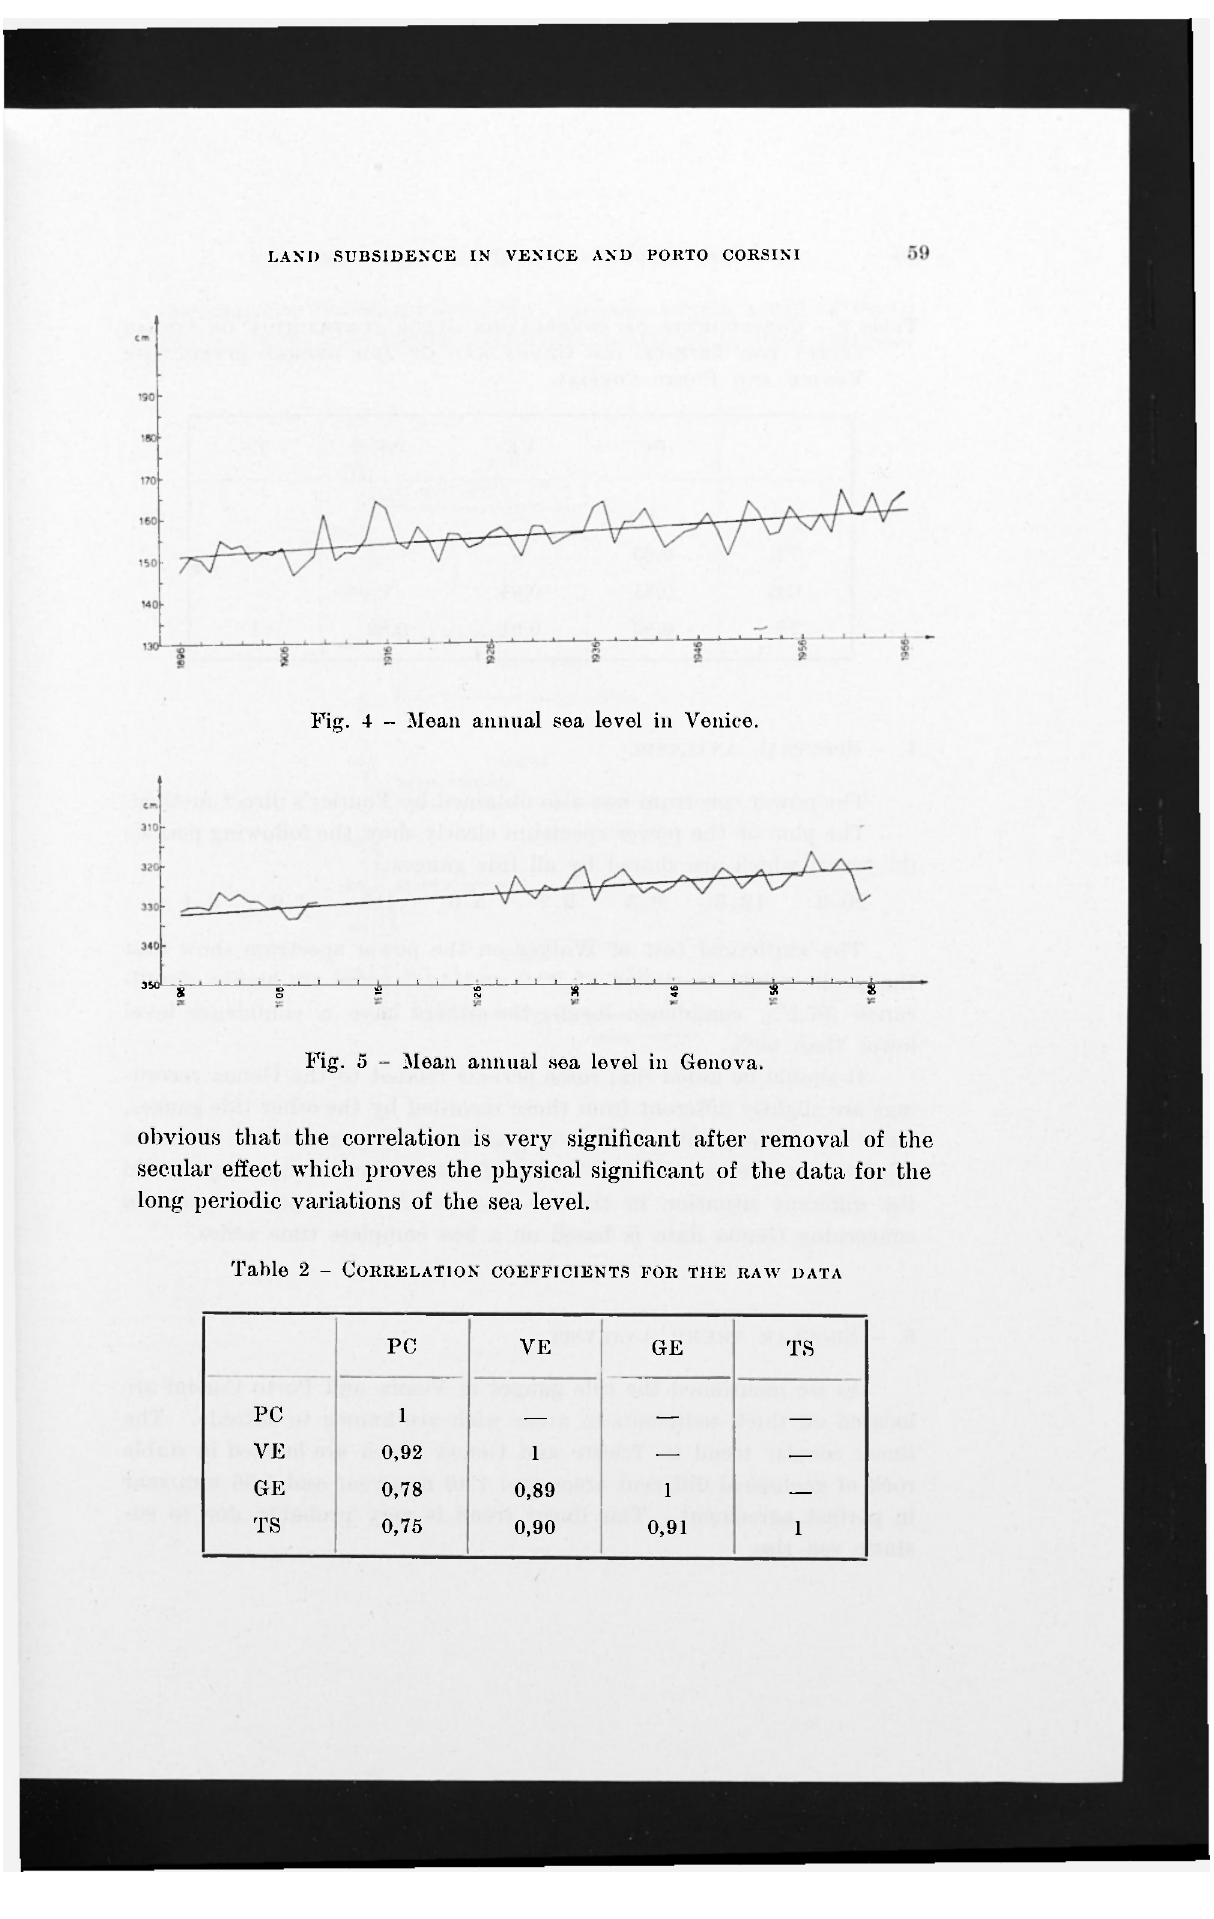
Fig. 4 - Mean annual sea level in Venice.